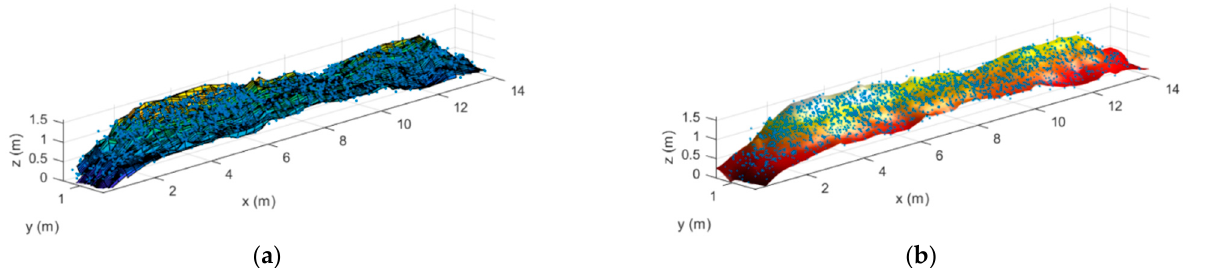
Figure 9. Surface reconstruction of the real stockpile following ( a ) proc1 and ( b ) proc2 procedures.